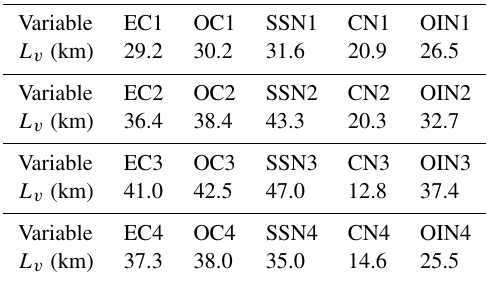
Table 1. Horizontal correlation length scales for individual aerosol state